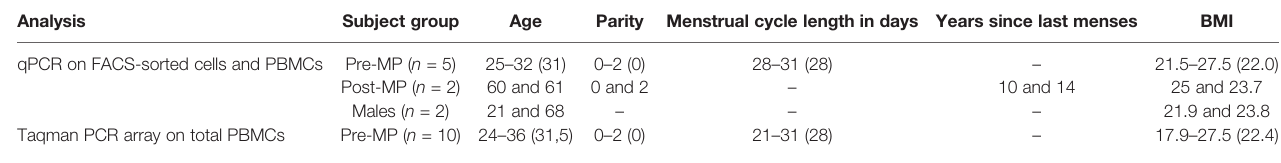
TABLE 1 | Clinical characteristics of participants, range